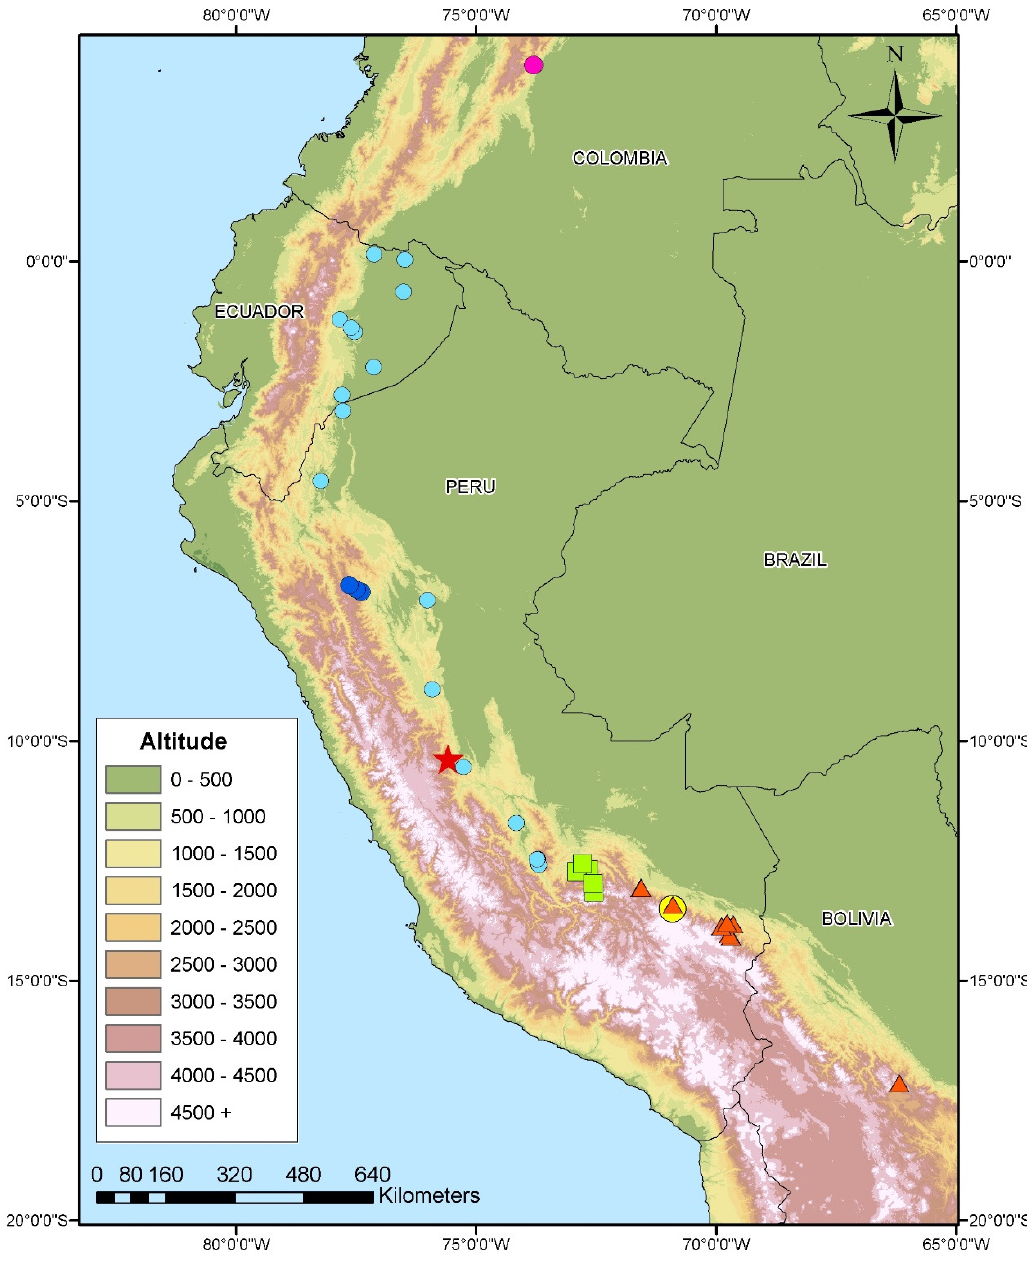
Figure 1. Geographic distribution of species of the genus Cercosaura in the Cordillera de los Andes. Orange triangles = “ Cercosaura manicata boliviana ”; light-blue circle = C. manicata ; purple circle = C. hypnoides ; blue circle = C. doanae ; green square = C. anomala ; red star = C. pacha sp. nov.; yellow circle = Cercosaura sp. Data taken from the literature [16,17,30] and museum records.